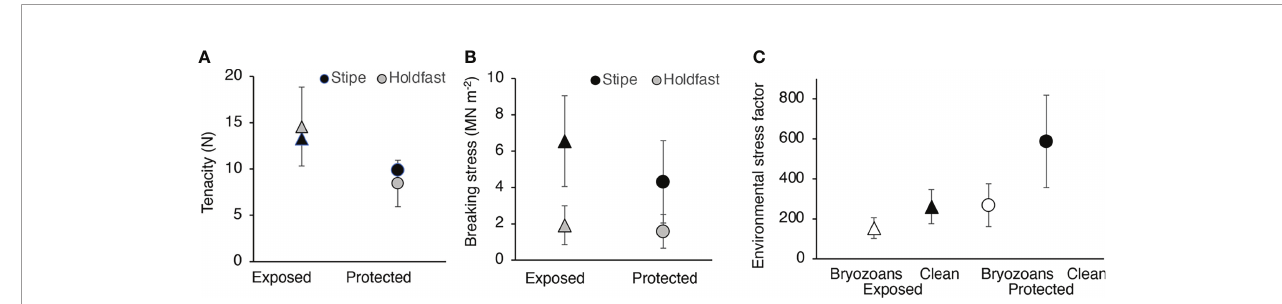
FIGURE 9 | Dislodgement of M. splendens . (A) Tenacity (force required to dislodge an alga) of individuals that broke at the stipe (black symbols) or failed at the holdfast (grey symbols) at the exposed site (triangles) and at the protected site (circles). Although there was no signi fi cant difference (p > 0.05) between the tenacity of stipes and holdfasts at each site, the tenacity of the holdfasts at the exposed site was signi fi cantly higher than that of the holdfasts and the stipes at the protected site (p < 0.05, one-way ANOVA followed by Tukey HSD test, F = 4.74 3,38 ), but there was no signi fi cant difference between the stipe tenacity of algae at the two sites (p > 0.05). (B) Breaking stress of the stipe (force per cross-sectional area, black symbols) and failure stress of the holdfast (force per area of attachment, grey symbols) of algae at the exposed site (triangles) and at the protected site (circles). The breaking stress of the stipes was signi fi cantly higher than the failure stress of the holdfasts for algae at the exposed site (p < 0.01, one-way ANOVA followed by Tukey HSD test, F = 12.97 3,38 ) and at the protected site (p < 0.01), but there was no difference between sites of stipe breaking stress (p > 0.05) or of holdfast failure stress (p > 0.05). This indicates that differences in tenacity in A were due to differences in stipe cross-sectional areas or holdfast attachment areas rather than in stipe tissue strength or in holdfast glue strength. (C) Environmental stress factor (ESF) for M. splendens at the exposed site (triangles) and at the protected site (circles). The stipe-breaking or holdfast-failure stress of each alga at the exposed site was divided by the stress due to the mean drag on an alga fouled by bryozoans (white triangles) or on a clean, unfouled alga (black triangles) at the exposed site hit by a ferry wake ( Figure 7 ). At the exposed site, the ESF of clean algae was signi fi cantly greater than the ESF of algae fouled with bryozoans (p < 0.01, one-way ANOVA followed by Tukey HSD test, F= 20.67 1,34 ). The stipe-breaking or holdfast-failure stress of each alga at the protected site was divided by the stress due to the mean drag on an alga fouled by bryozoans (white circles) or on a clean, unfouled alga (black circles) at the protected site hit by a ferry wake ( Figure 7 ). At the protected site, the ESF of clean algae was signi fi cantly greater than the ESF of algae fouled with bryozoans (p < 0.01, one-way ANOVA followed by Tukey HSD test, F= 37.72 1,46 ).